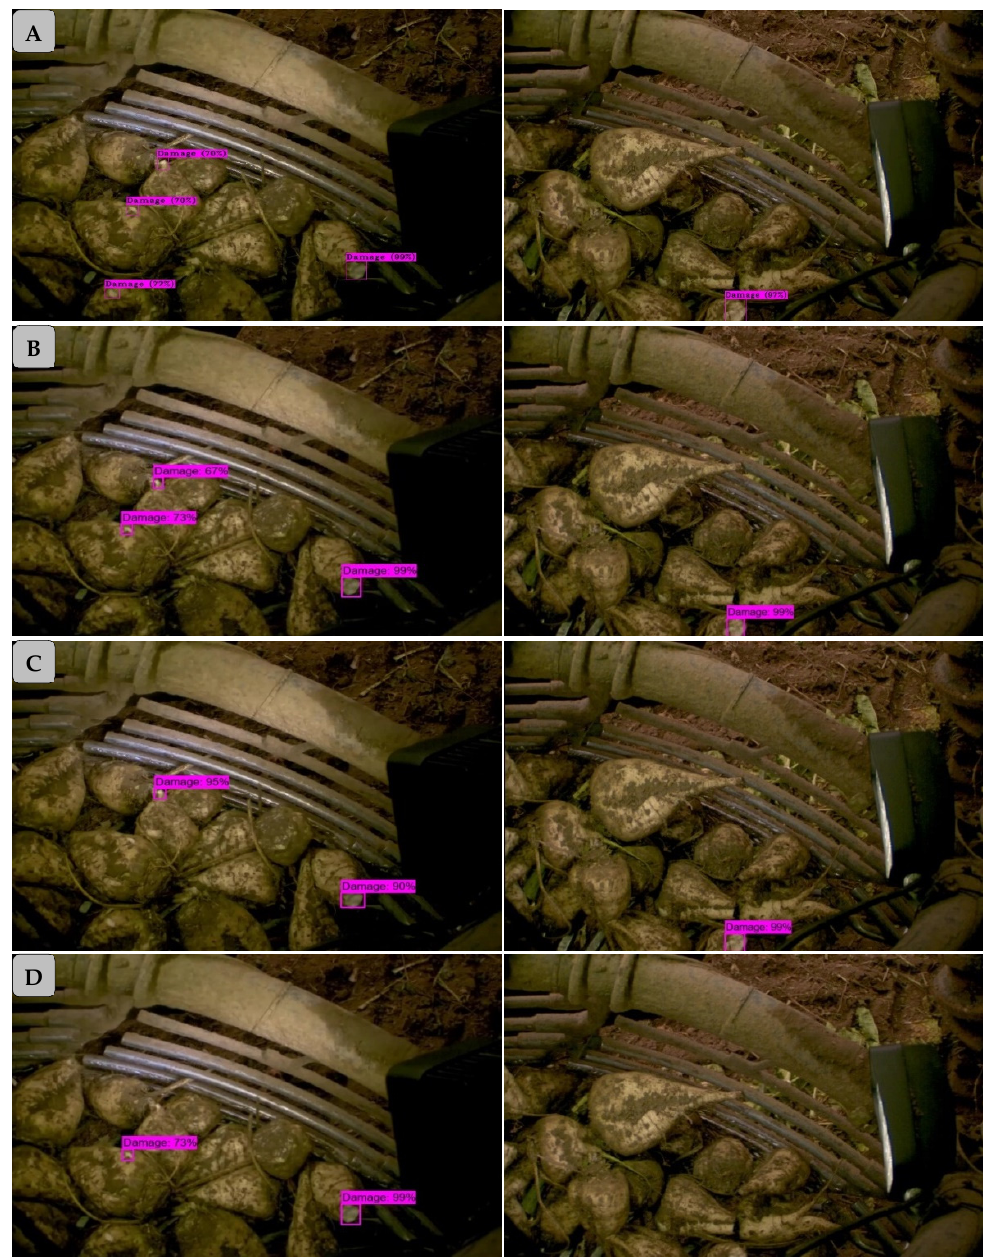
Figure 8. Sample of images of YOLO v4 ( A ), R-FCN ResNet101 ( B ), Faster R-CNN Inception V2 ( C ), and Faster R-CNN NAS ( D ) damage detection in a sugar beet harvester in different cleaning turbines and farms.